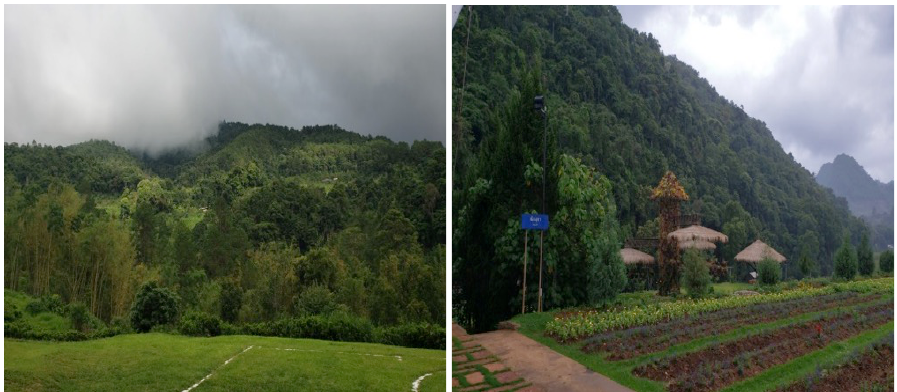
Note . Images captured during fieldwork in